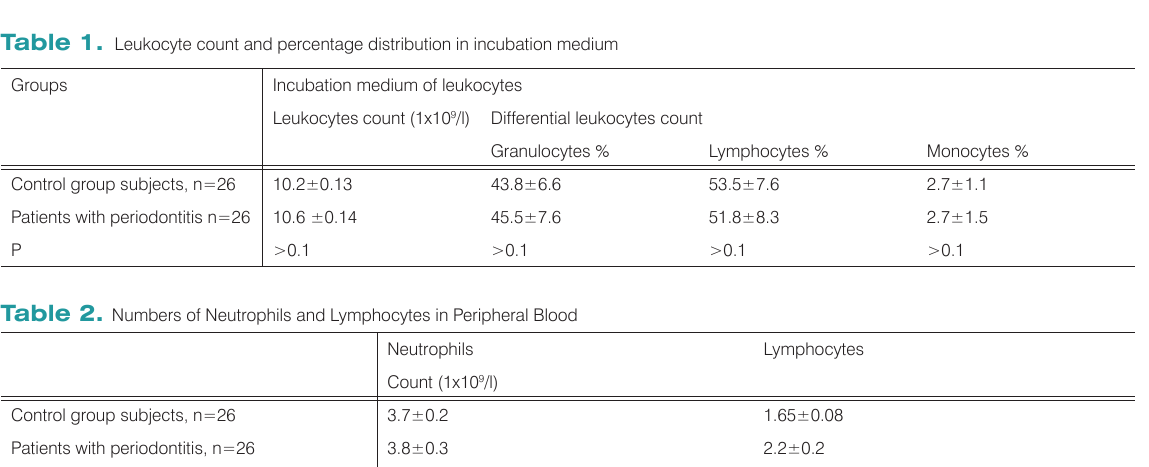
Figure 1. Descriptive statistics of Clinical measurements in study groups